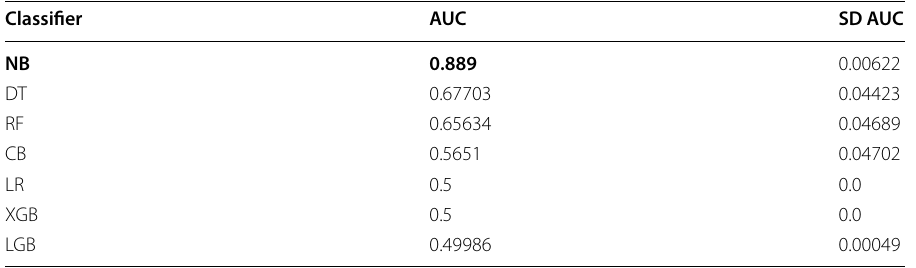
Bolded values indicate highest